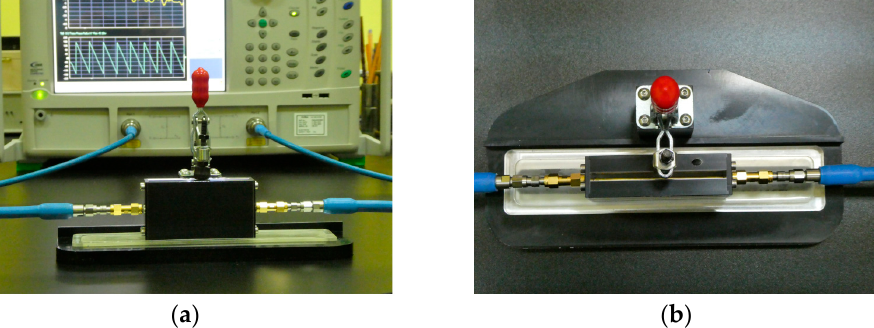
Figure 13. DiLine measurement setup used for liquid verification ( a ) vector network analyzer connected to TEM line, ( b ) TEM line.